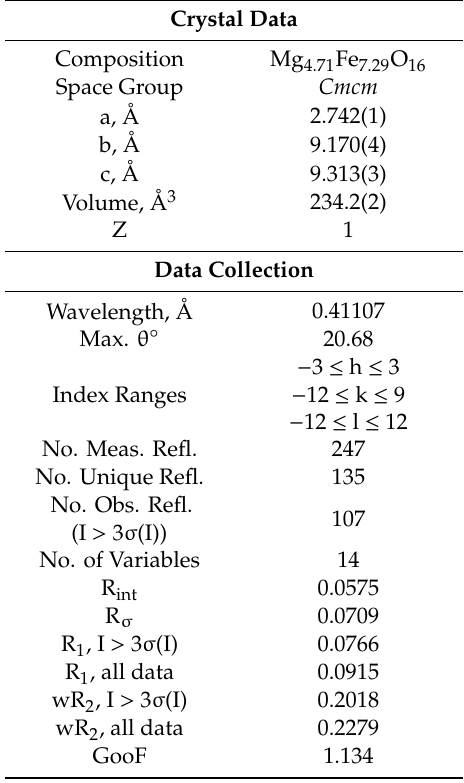
Table 4. Crystallographic data and refinement parameters for crystal C02 at 30.0(5) GPa.